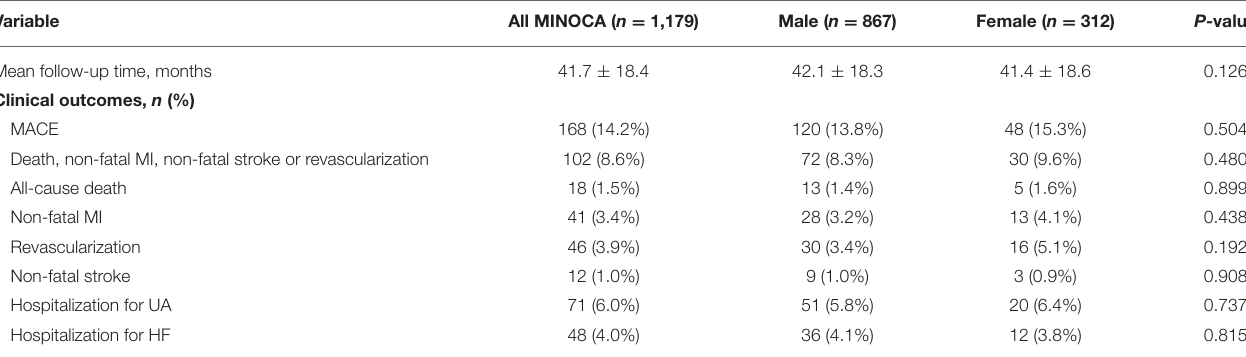
TABLE 2 | Clinical outcomes among male and female MINOCA patients.